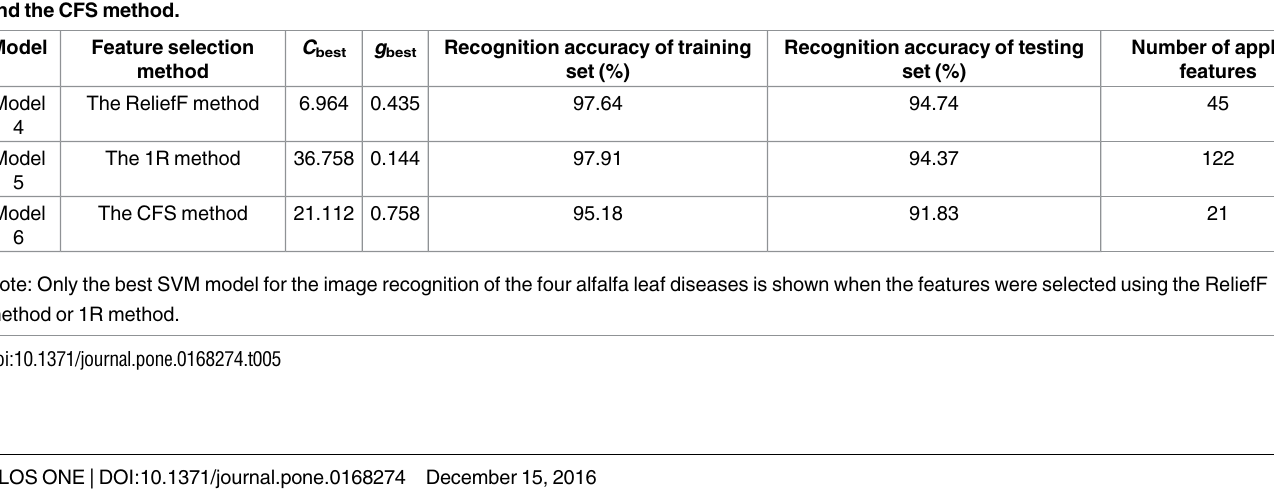
testing set was 87.30%. With increasing K value, the recognition accuracies of the training set and the testing set for the built KNN models shown in Table 6 decreased in small-scale ampli- tude, indicating that the best K value in this study was 5. Considering the recognition accura- cies of the training set and the testing set and the number of applied features for modeling, the optimality ranking of the three models shown in Table 6 was Model 7, Model 9, and Model 8. Recognition Results of Disease Recognition Models Based on Semi-supervised Learn- ing. Considering the recognition accuracies of the training set and the testing set and the number of applied features for modeling, Model 4 was regarded as the optimal model among the nine models described above. The recognition results of each type of alfalfa leaf disease using the optimal model are shown in Table 7. To eliminate the linear correlation between the features, the 45 features used for building Model 4 were transformed using PCA, and the changes in cumulative contribution rates with increasing number of principal components were achieved as shown in Fig 3. The results showed that the cumulative contribution rate of